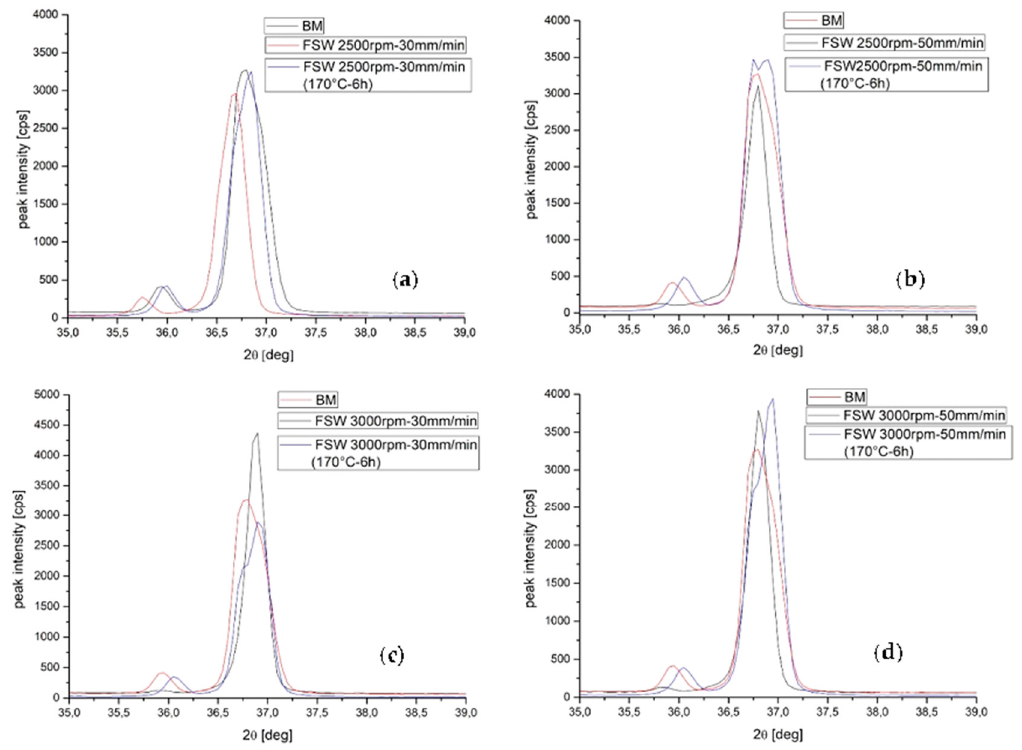
Figure 4. Comparison of X-ray diffractions of FSPed, aged samples at 170 °C-6 h and BM in the four FSP conditions: ( a ) 2500 rpm, 30 mm/min; ( b ) 2500 rpm, 50 mm/min; ( c ) 3000 rpm, 30 mm/min; ( d ) 3000 rpm, 50 mm/min. The lowest peaks are (330) β -Mg17Al12 and the highest are (10–11) Mg.